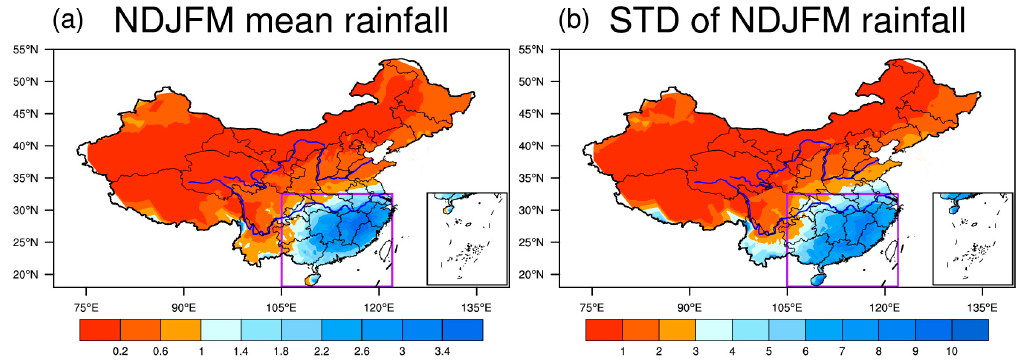
Figure 1. ( a ) Mean and ( b ) standard deviation of wintertime (NDJFM) rainfall in China during 1981–2013 derived from 2400 stations. Units: mm/day.